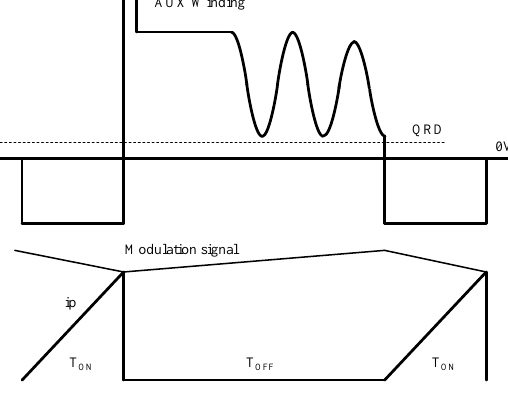
Figure 9. Disturbance voltage feedback signal.